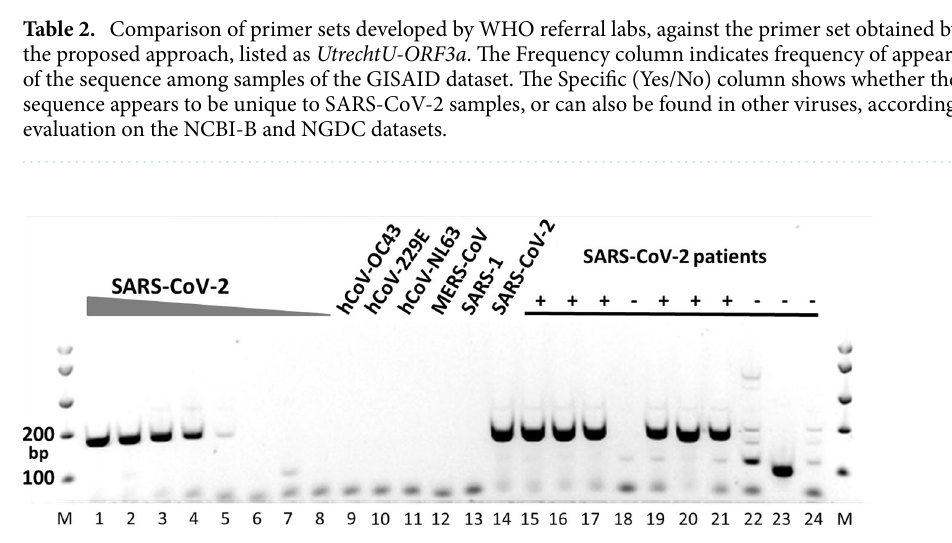
Figure 4. Laboratory validation of the candidate primer set by conventional PCR. MM, molecular weight marker; lanes 1–8, 10-fold dilutions of SARS-CoV-2 RNA (corresponding to Ct values 26–39 in the diagnostic reference assay); lanes 9–14, RNA from different human coronaviruses (hCoV-OC43, hCoV-229E, hCoV-NL63, MERS-CoV, SARS-1, SARS-CoV-2, respectively); lanes 15, 16, 17, 19, 20, 21, patient samples previously found positive for SARS-CoV-2; lanes 18, 22, 23, 24, patient samples previously found negative for SARS-CoV-2.